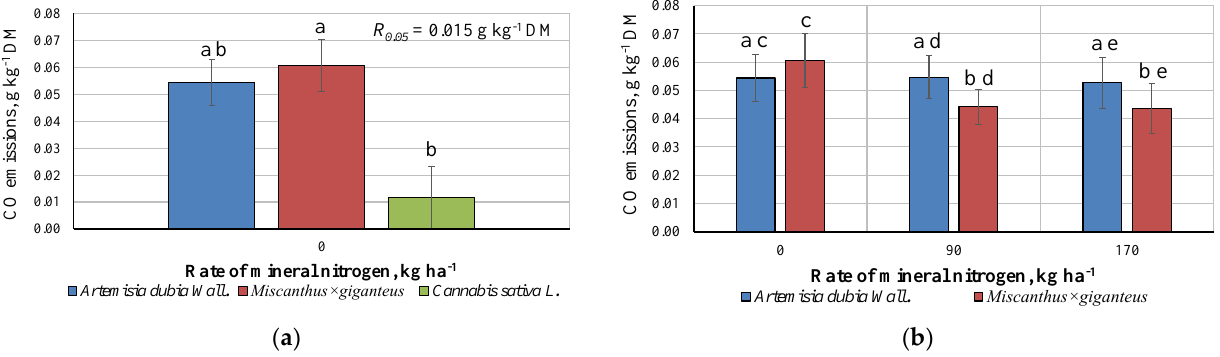
Figure 8. The dependence of CO emissions of Artemisia dubia Wall., Miscanthus×giganteus and Cannabis sativa L. not fertilized ( a ), on mineral nitrogen fertilization ( b ) ( R 0.05 ( A. dubia ) = 0.013 g kg −1 DM, R 0.05 ( M. giganteus ) = 0.013 g kg −1 DM, R 0.05 ( A. dubia × M. giganteus ) = 0.010 g kg −1 DM. a, b, c, d, e, there are no statistically significant differences ( p < 0.05) between the columns marked with the same letter, as assessed using the least significant difference.